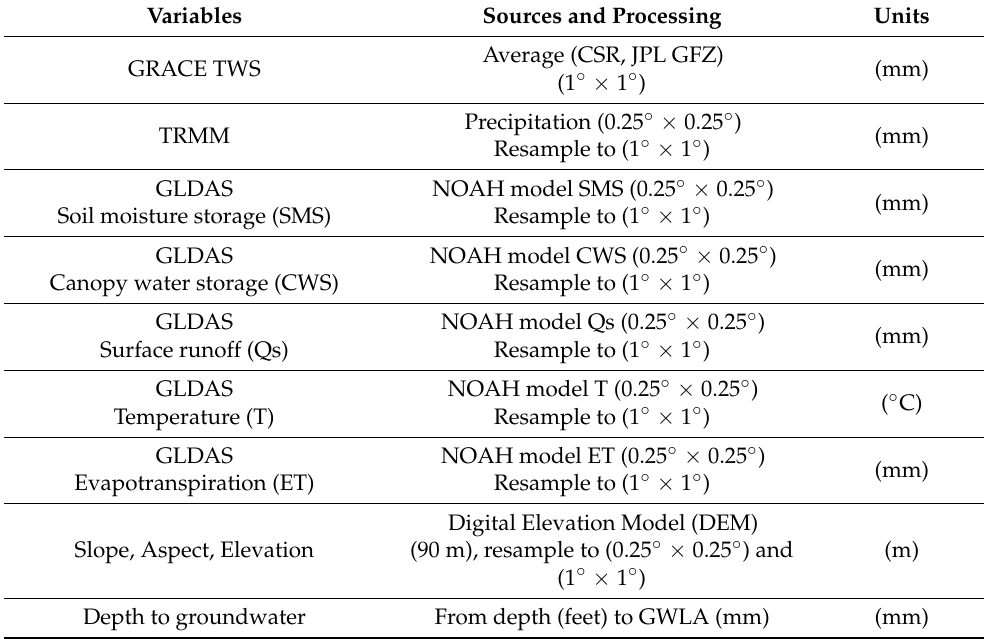
Table 1. Summary of the data used. Variables Sources and